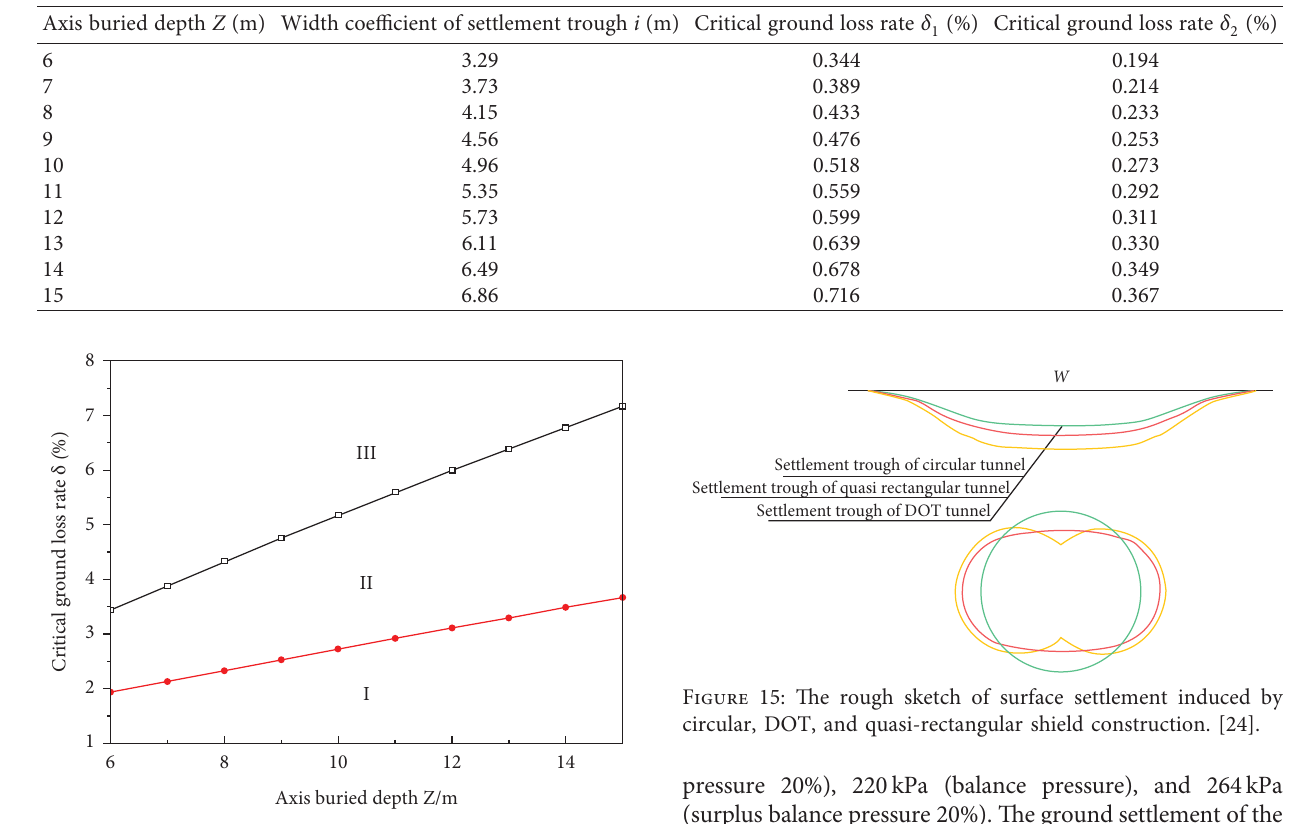
Table 3: The critical ground loss ratio of different tunnel depths [24].